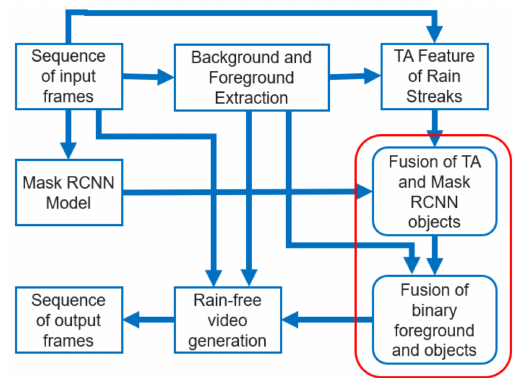
Figure 2. Block diagram of the proposed